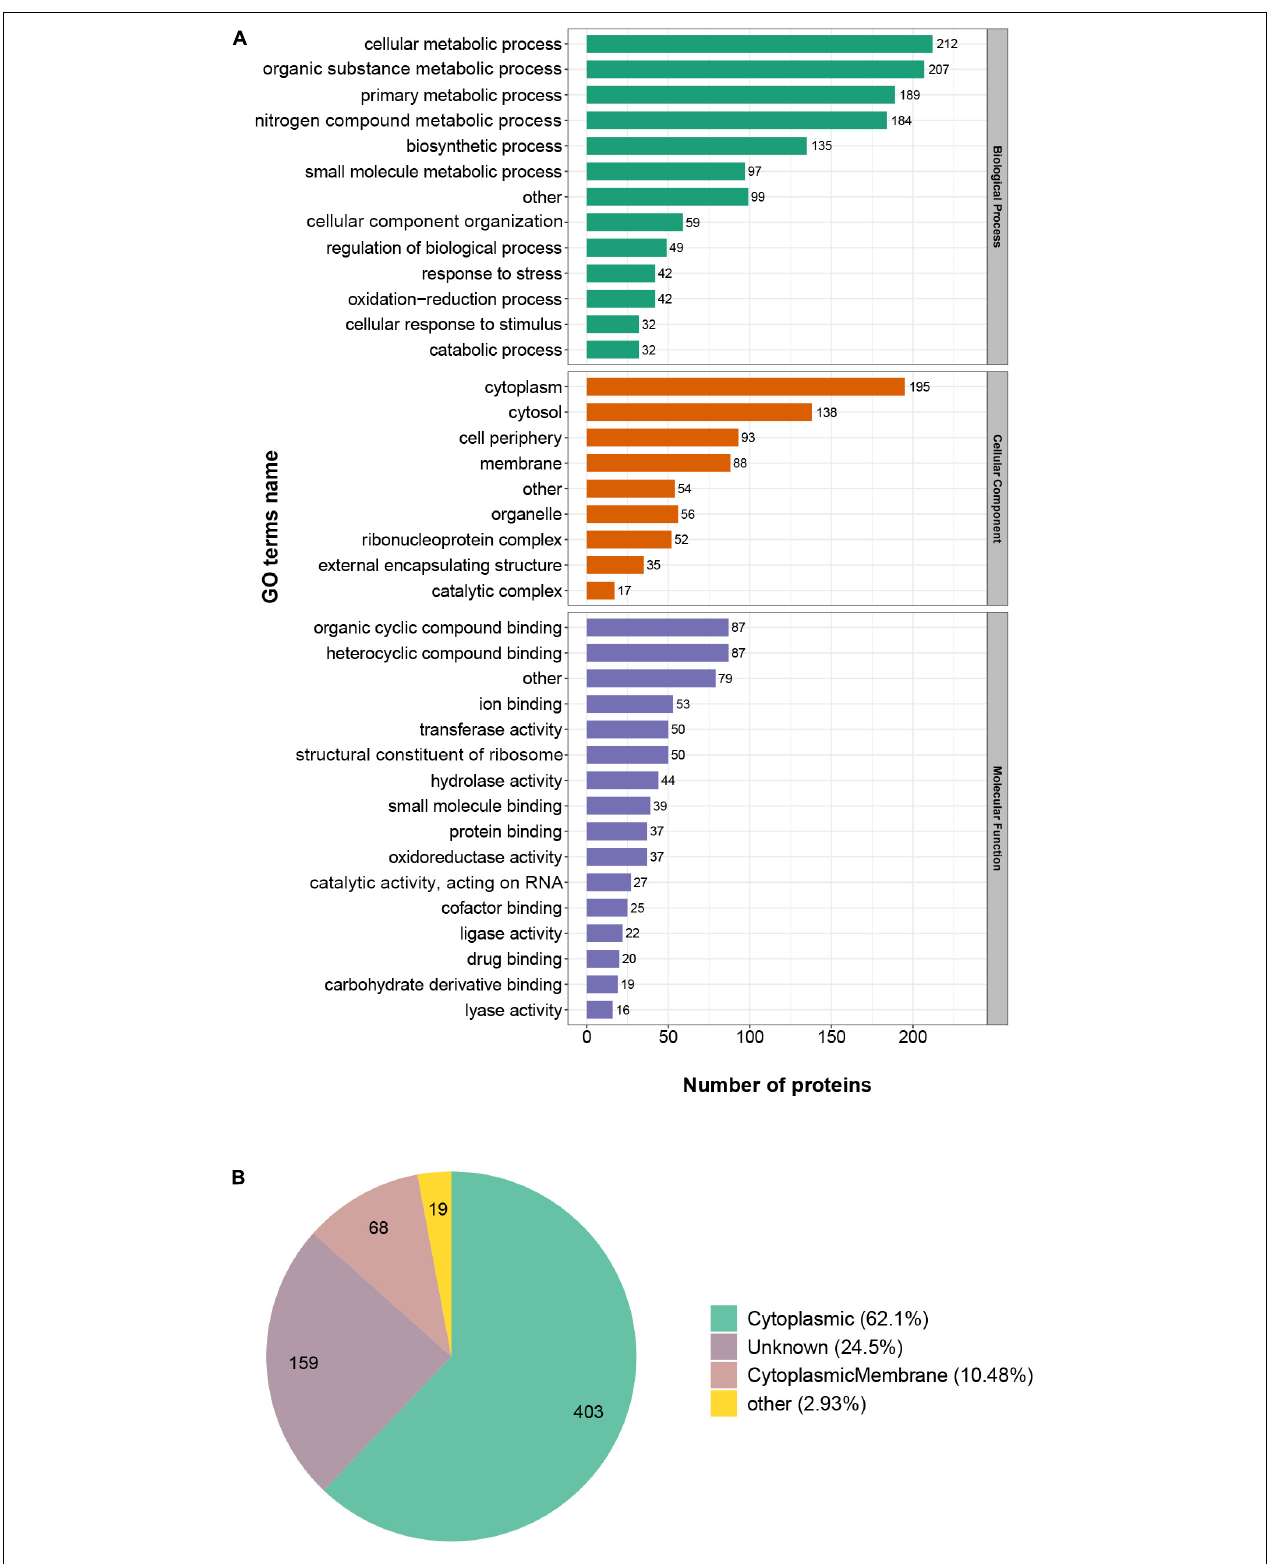
FIGURE 3 | Gene Ontology functional classification of succinylated proteins in Staphylococcus epidermidis . (A) Classification of succinylated proteins on the basis of biological process (BP), molecular function (MF), and cellular component (CC). (B) Classification of succinylated proteins on the basis of subcellular location.